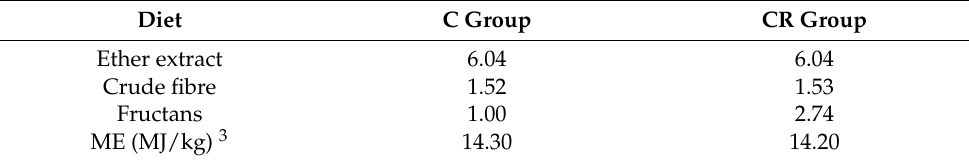
Table 1. Cont. Diet C Group CR Group Ether extract Crude fibre